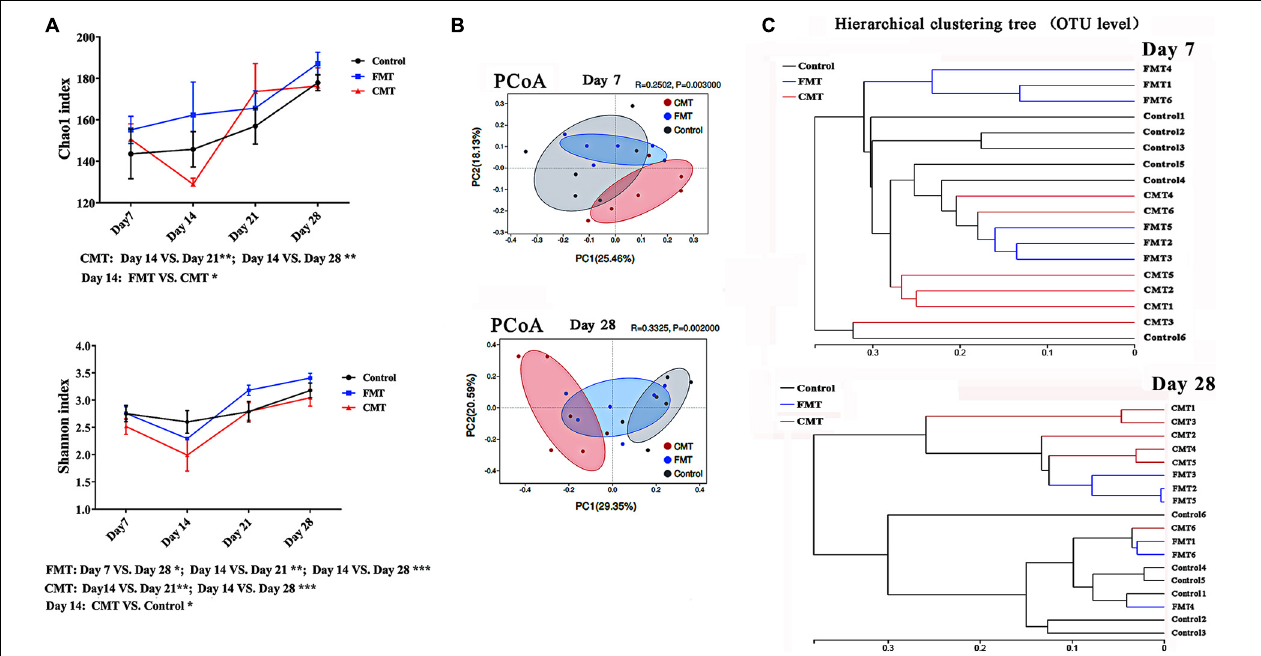
FIGURE 5 | Diversity changes of intestinal microbiota in different piglets. (A) Changes in alpha diversity indexes (Chao and Shannon indexes, at the OTU level) of the gut microbiota in piglets after transplantation. * Indicates P < 0.05, ** indicates P < 0.01, and *** indicates P < 0.001; (B) Principle coordinate analysis (PCoA) plot based on the OTUs in different piglets on day 7 and day 28. (C) Hierarchical clustering analysis of the OTUs in different piglets on day 7 and day 28.